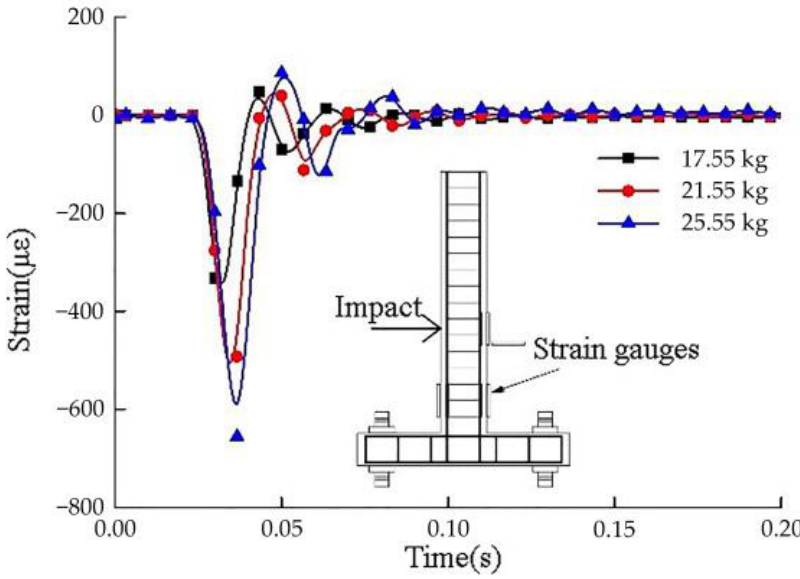
Figure 10. Strain time history of concrete with different impact masses.